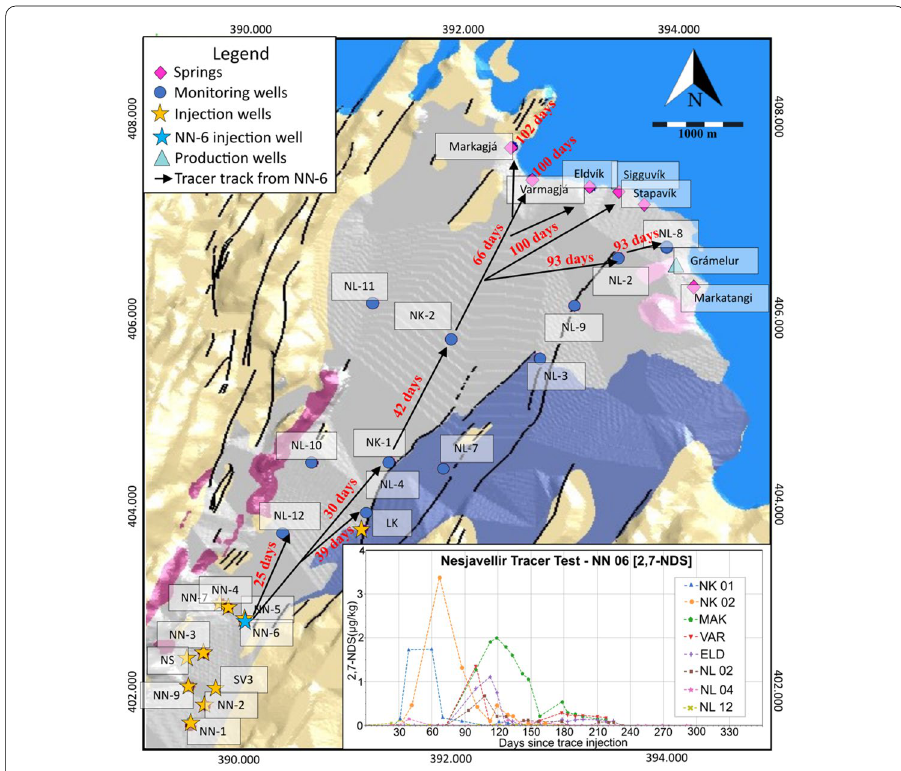
Fig. 5 Tracer test performed in 2018–2019. Injection of 2,7‑NDS tracer injected in NN‑6 (blue star). Map illustrates the trajectory and measured recovery times of 2,7‑NDS between injection and monitoring